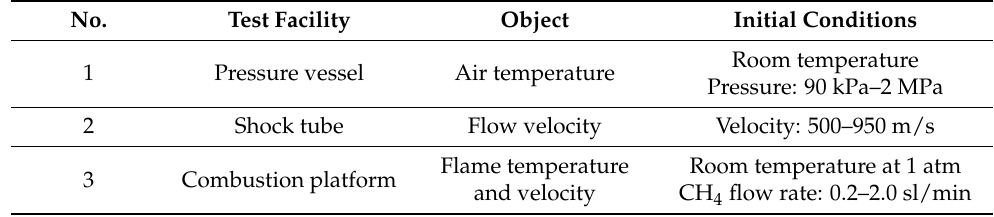
Table 2. Experimental conditions for tests by three